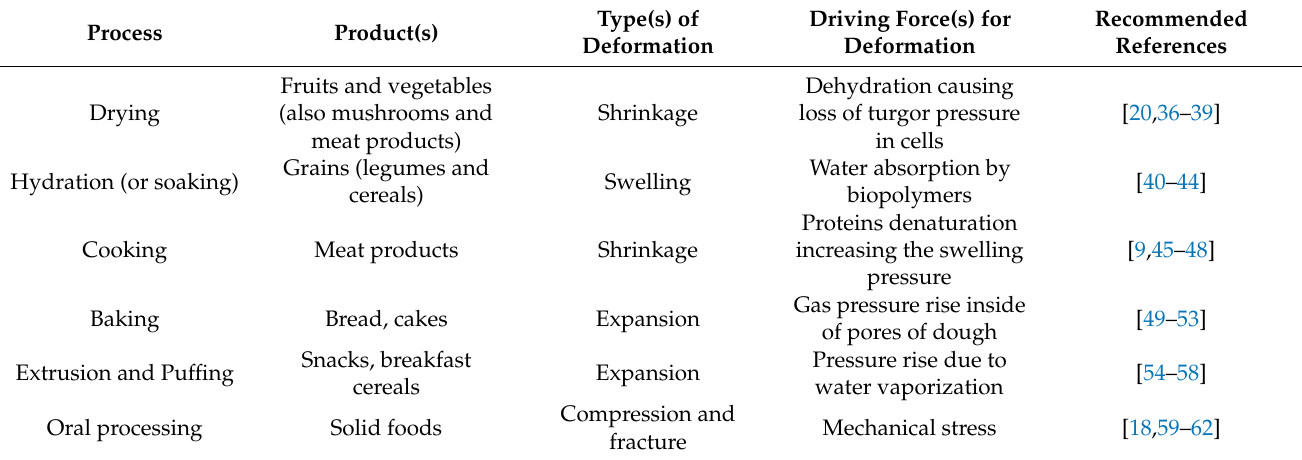
Table 1. Summary of applications discussed in Section 3, as a reference